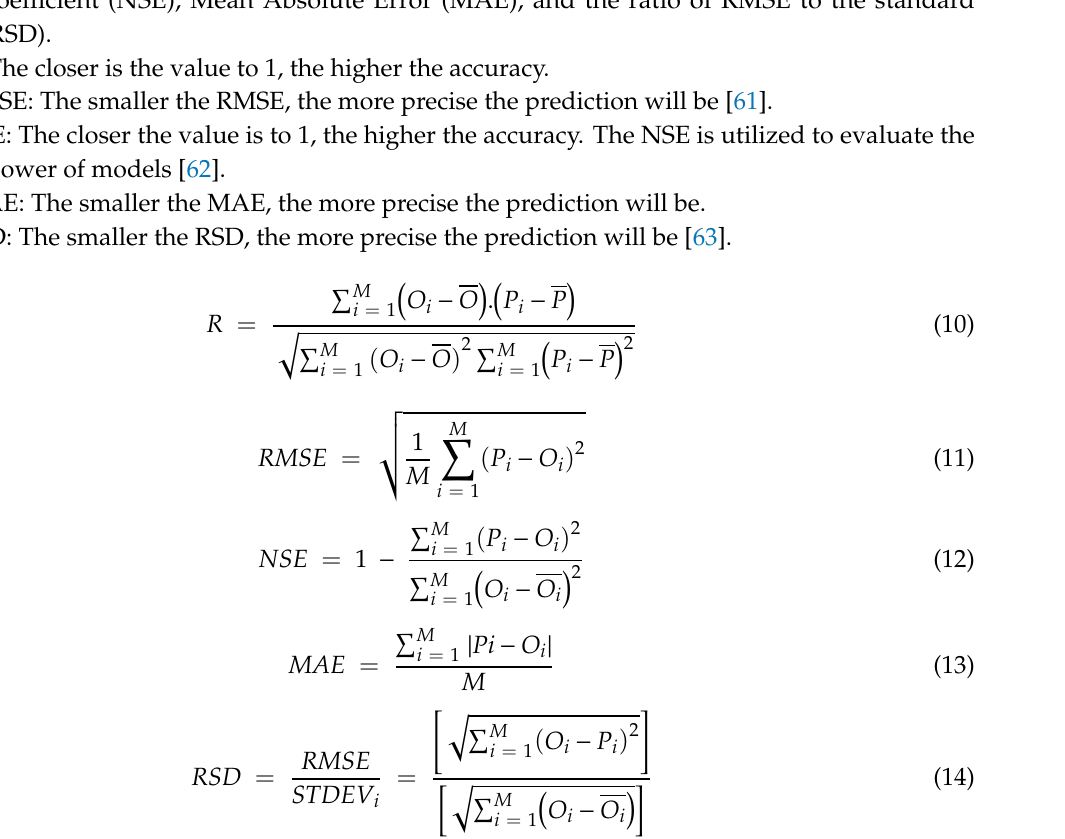
e ffi ciency coe ffi cient (NSE), Mean Absolute Error (MAE), and the ratio of RMSE to the standard deviation